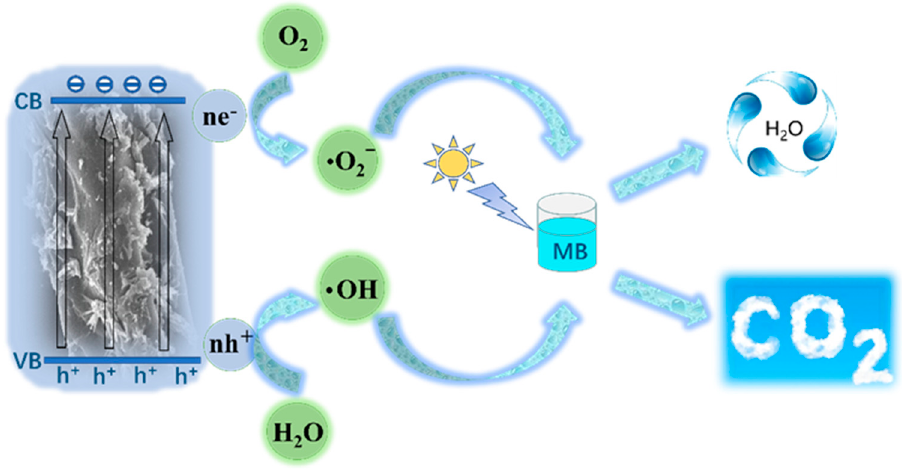
Figure 10. Schematic diagram of the photocatalytic mechanism for TiO 2 /CRFs photocatalyst under sunlight irradiation.